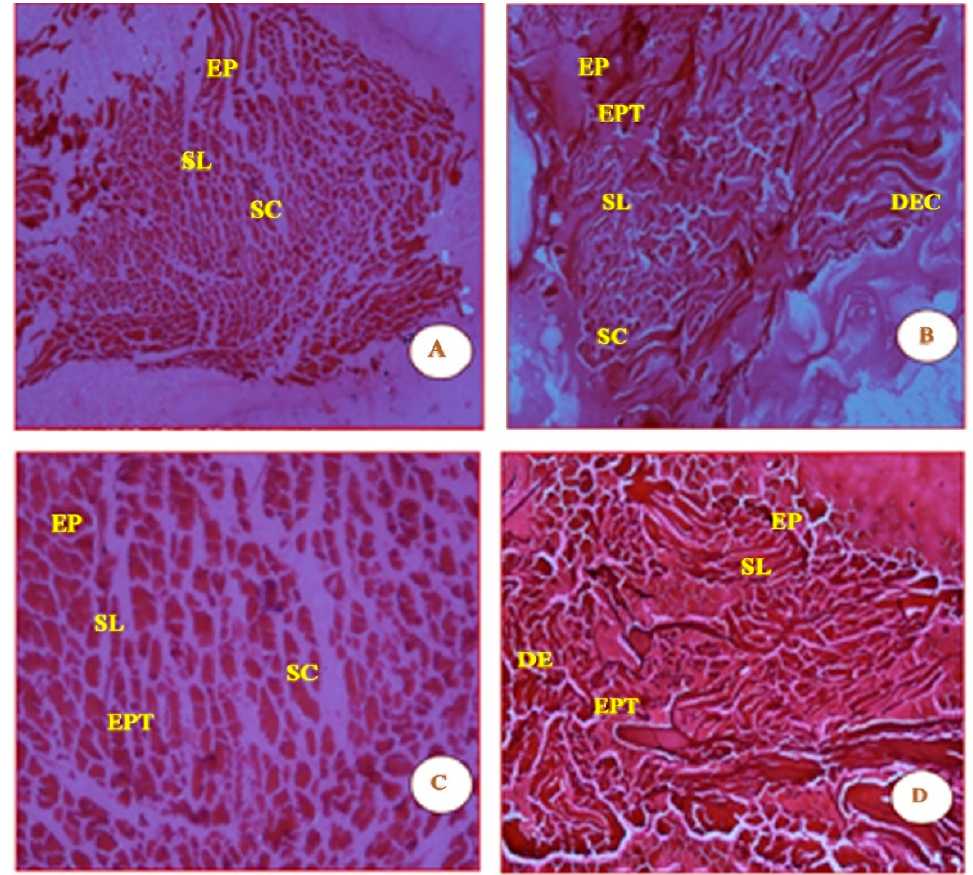
Figure 2. Micrographs (A, B, C and D) are shown of control fish G. giuris muscle sections stained with haematoxylin and eosin. The micrographs also depict clearly defined features in the four panels which are labelled as follows: epidermis (EP), stratum laxum (SL), stratum compactum (SC), epithelial tissue (EPT), dermis (DE), and dense epidermal cells (DEC). The magnification of each panel ( A – D ) was 4X, 10X, 20X, and 40X, respectively.